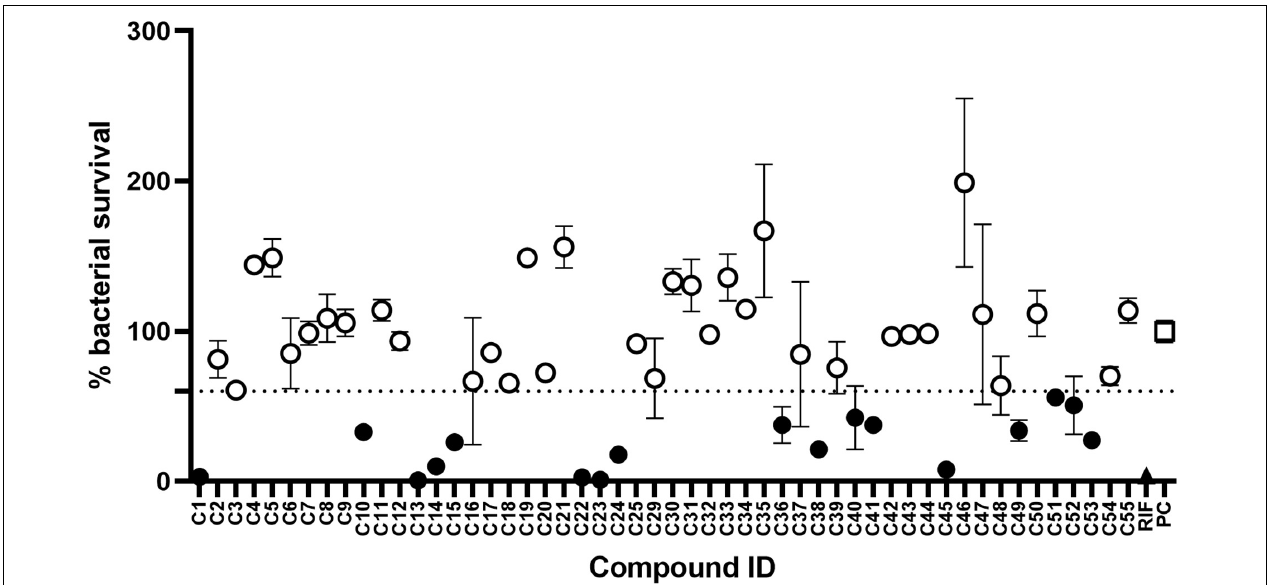
FIGURE 5 | Compound library screen against Mycobacterium tuberculosis . Log phase M. tuberculosis was treated with compounds at 100 µ g/mL for 7 days, bacterial survival was measured after overnight incubation with CellTiter-Blue. Data points are expressed as mean % survival compared to drug-free controls. Error bars represent the standard deviation. Hits were classified as any compound that inhibited growth by ≥ 40%. Filled circles identify hit compounds. Empty circles indicate compounds not classified as hits. The mean bacterial survival ≤ 60% shown as a dotted line. Filled triangle (RIF) marks rifampicin-treated bacilli. Empty square (PC) indicates drug-free positive